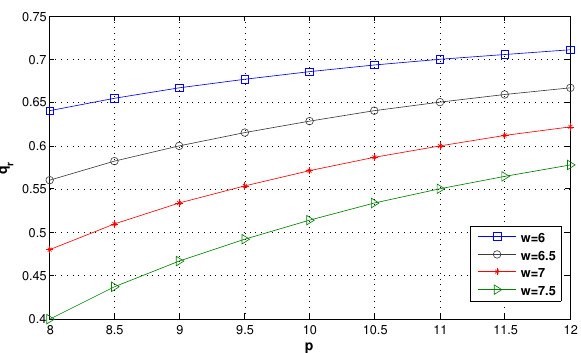
Figure 3. The optimal order quantity of the retailer under different wholesale prices.